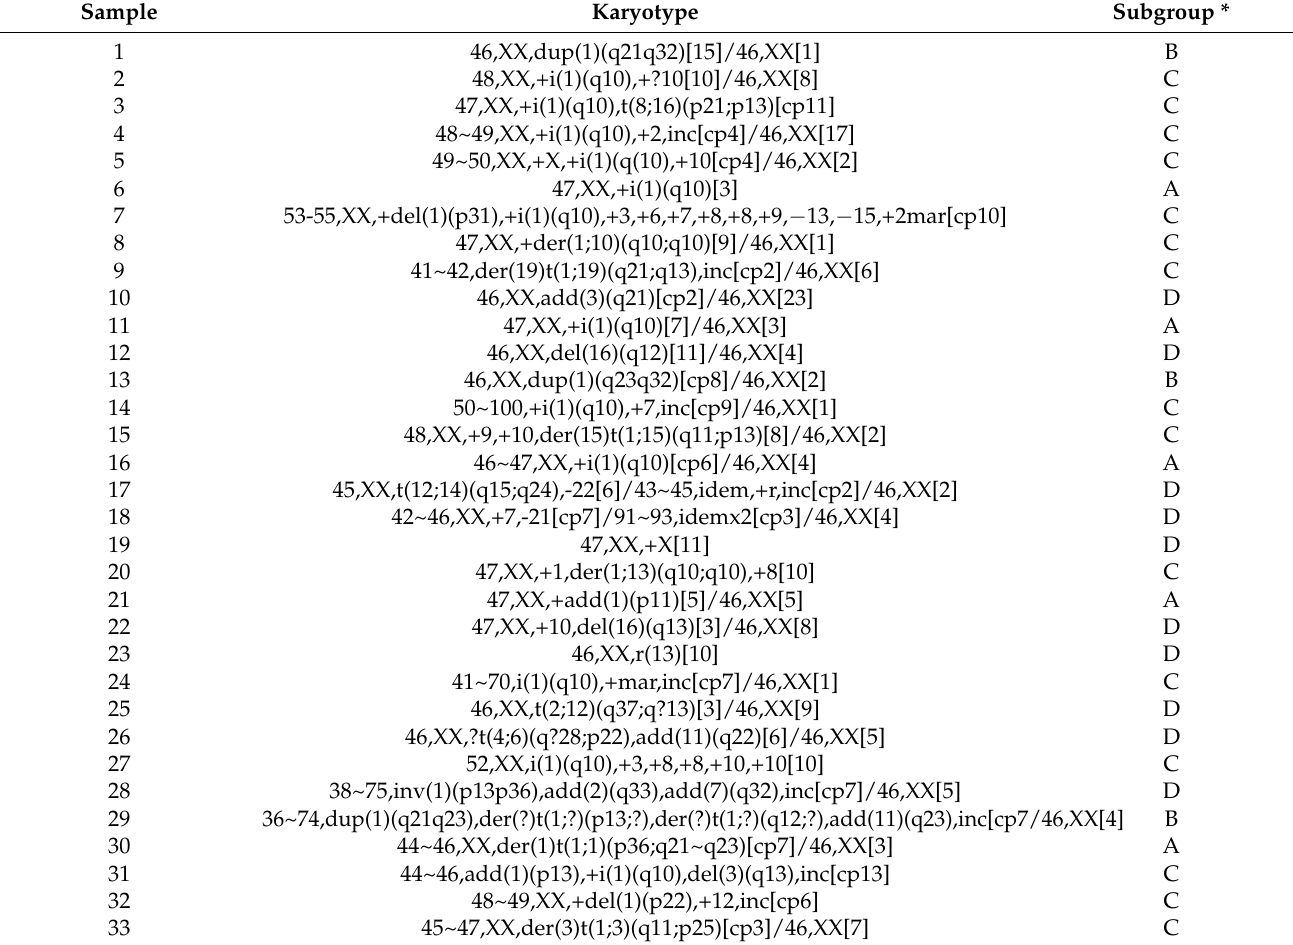
Table 3. Overview of the karyotypes for